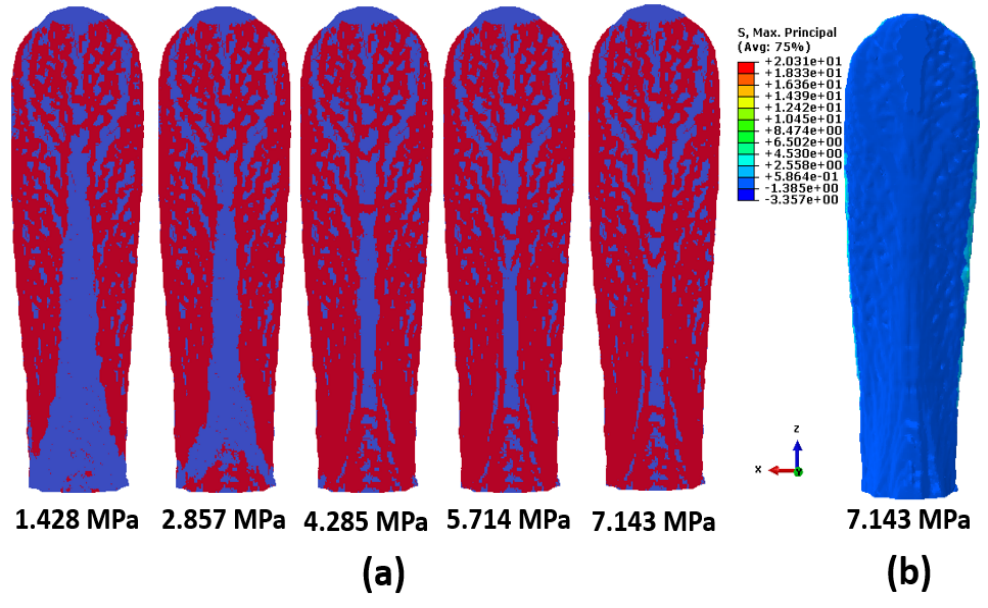
Figure 19. Tissue of paddlefish rostrum. ( a ) Network flow analysis on the top surface of the rostrum subjected to uniform pressure loading with a fixed plate boundary condition. Nodes are colored by their respective locations on the source (red) or sink (blue) side of the minimum cut. ( b ) Maximum principal stresses on the top surface of rostrum.